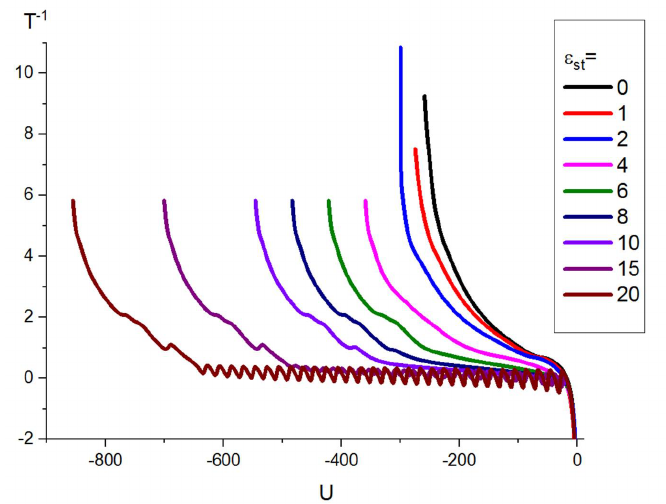
Figure 2. Microcanonical analysis data for the inverse temperature as a function of the potential (conformational) energy for the case “F-attract-stronger” (F, Flexible), b = 16. The different curves are for different stiffness energies ε st given in the